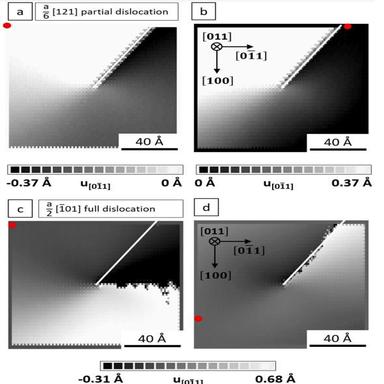
-Displacement maps obtained by TeMA on virtual crystal featuring a a 6 partial dislocation (a,b) and aa 2 full dislocation (c,d) for different reference lattice origins indicated by the red dots. The site of the dislocation plane as known from the simulation is indicated by white solid lines.